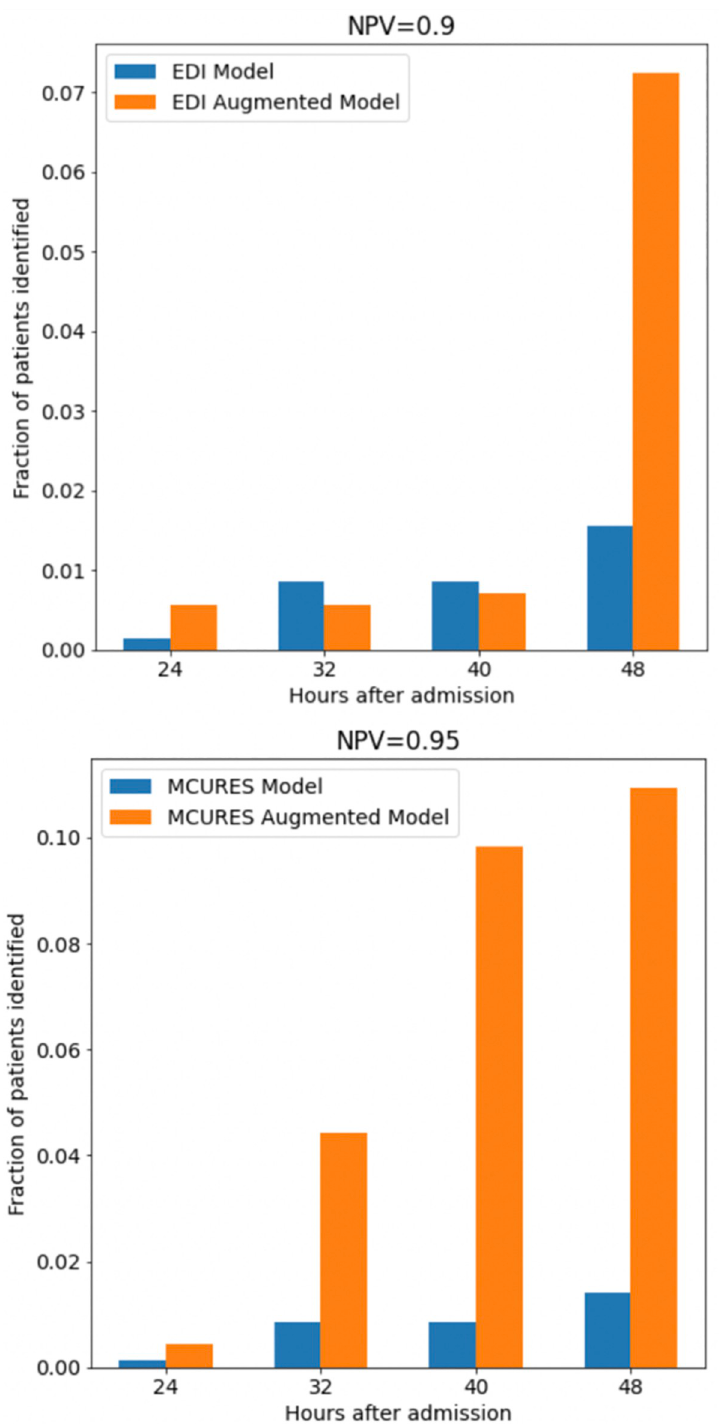
Fig 4. The fraction of patients correctly identified by each of the models as low-risk, shown over hours after hospital admission. Note that the MCURES and MCURES-augmented models generally have better performance over the EDI and EDI-augmented models and so we select 0.9 NPV as an appropriate cutoff for EDI and 0.95 NPV for MCURES.